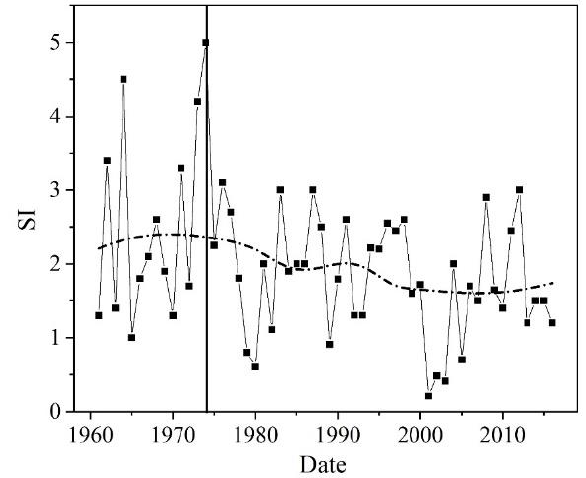
Figure 8. Temporal variation in SI . The dotted line is the Loess function fitting curve.